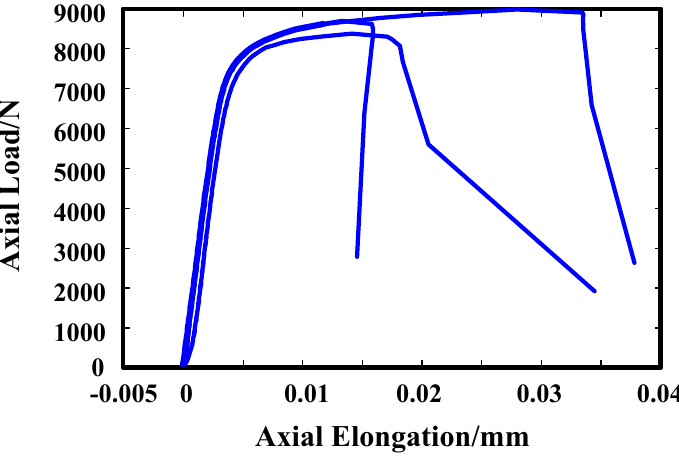
Figure 4. The axial load-axial elongation curve of multiple